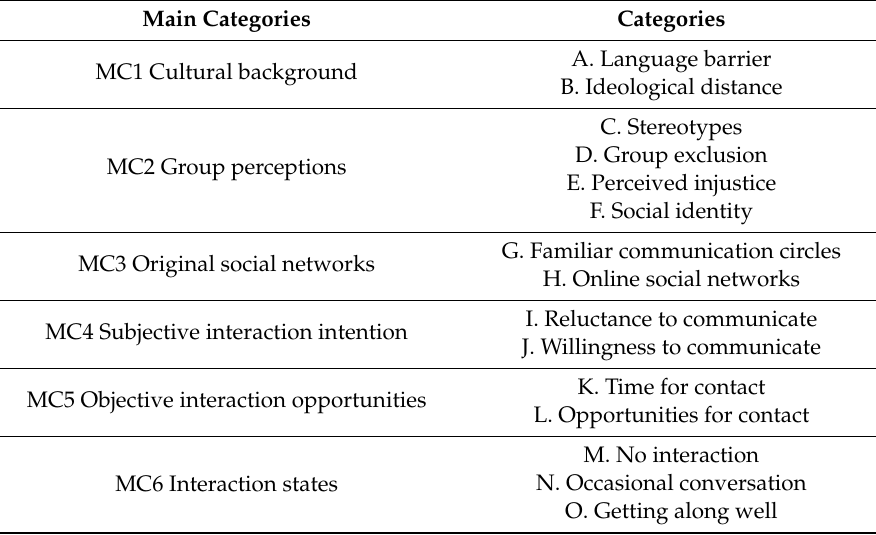
Table 3. Main and subcategories in axial coding analysis.